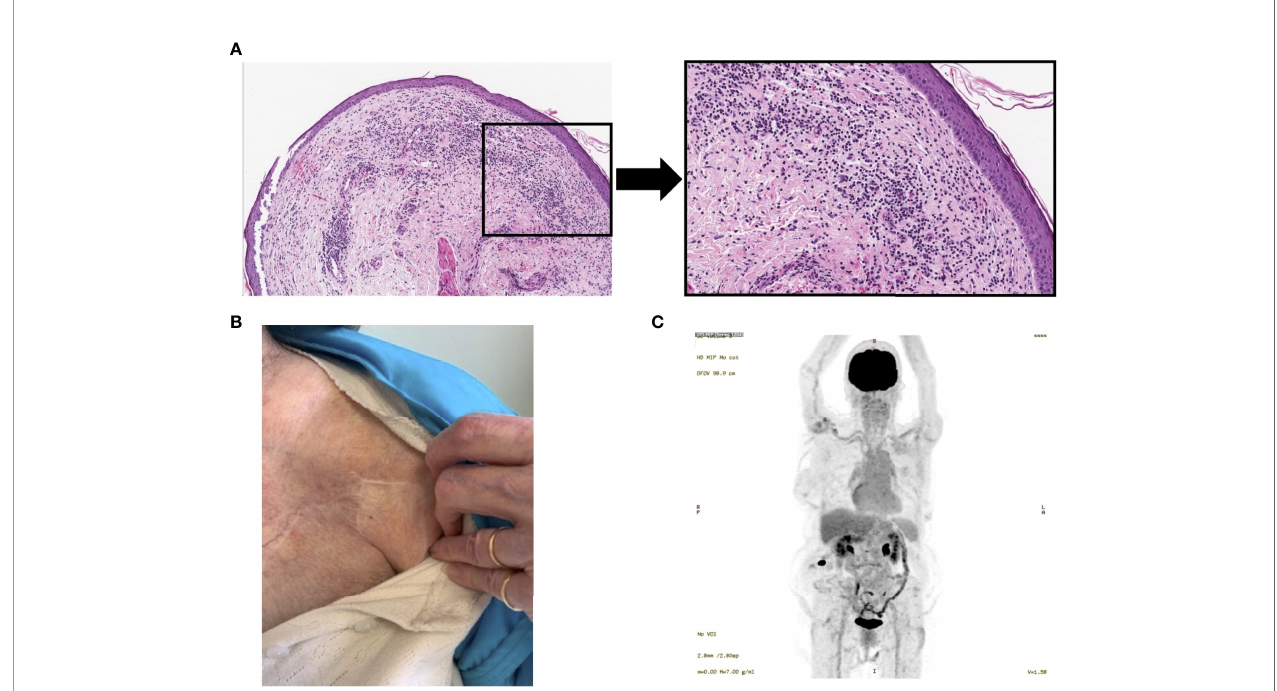
FIGURE 3 | Resolution of cutaneous metastasis following intralesional IL-2 and topical imiquimod. (A) Punch biopsy of injected site at the 14-week timepoint, 100X magni fi cation (left) and representative section, 200X magni fi cation (right) showing no evidence of adenocarcinoma, with chronic immune in fi ltrates. (B) Image of lesion post-treatment, showing complete clinical response. (C) Post-treatment PET-CT (2 weeks after the fi nal treatment; week 34) revealing no evidence of PET-avid lesions overlying the left pectoral